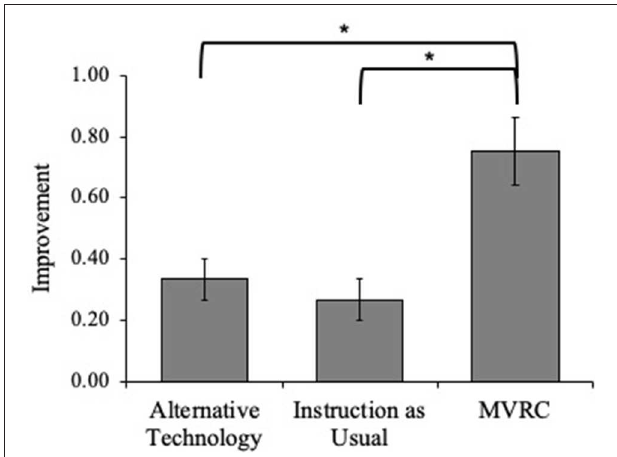
FIGURE 7 | Average improvement of 2nd-grade reading fluency as a function of condition. Error bars represent standard errors. *Significant difference obtained with Bonferroni pair-wise comparisons ( p < 0.01).